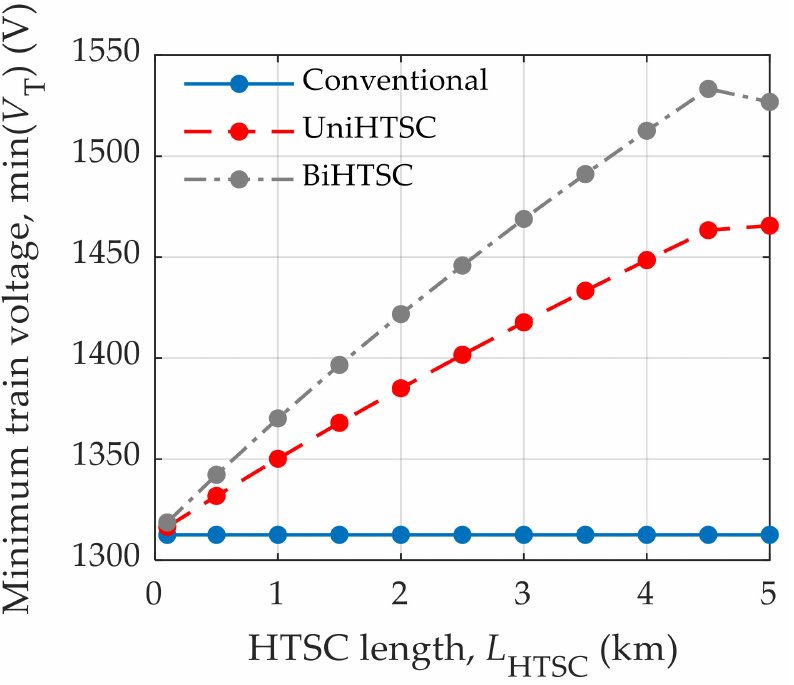
Figure 15. Minimum voltage of the train as a function of the length of the superconducting cable power equal to 4.2